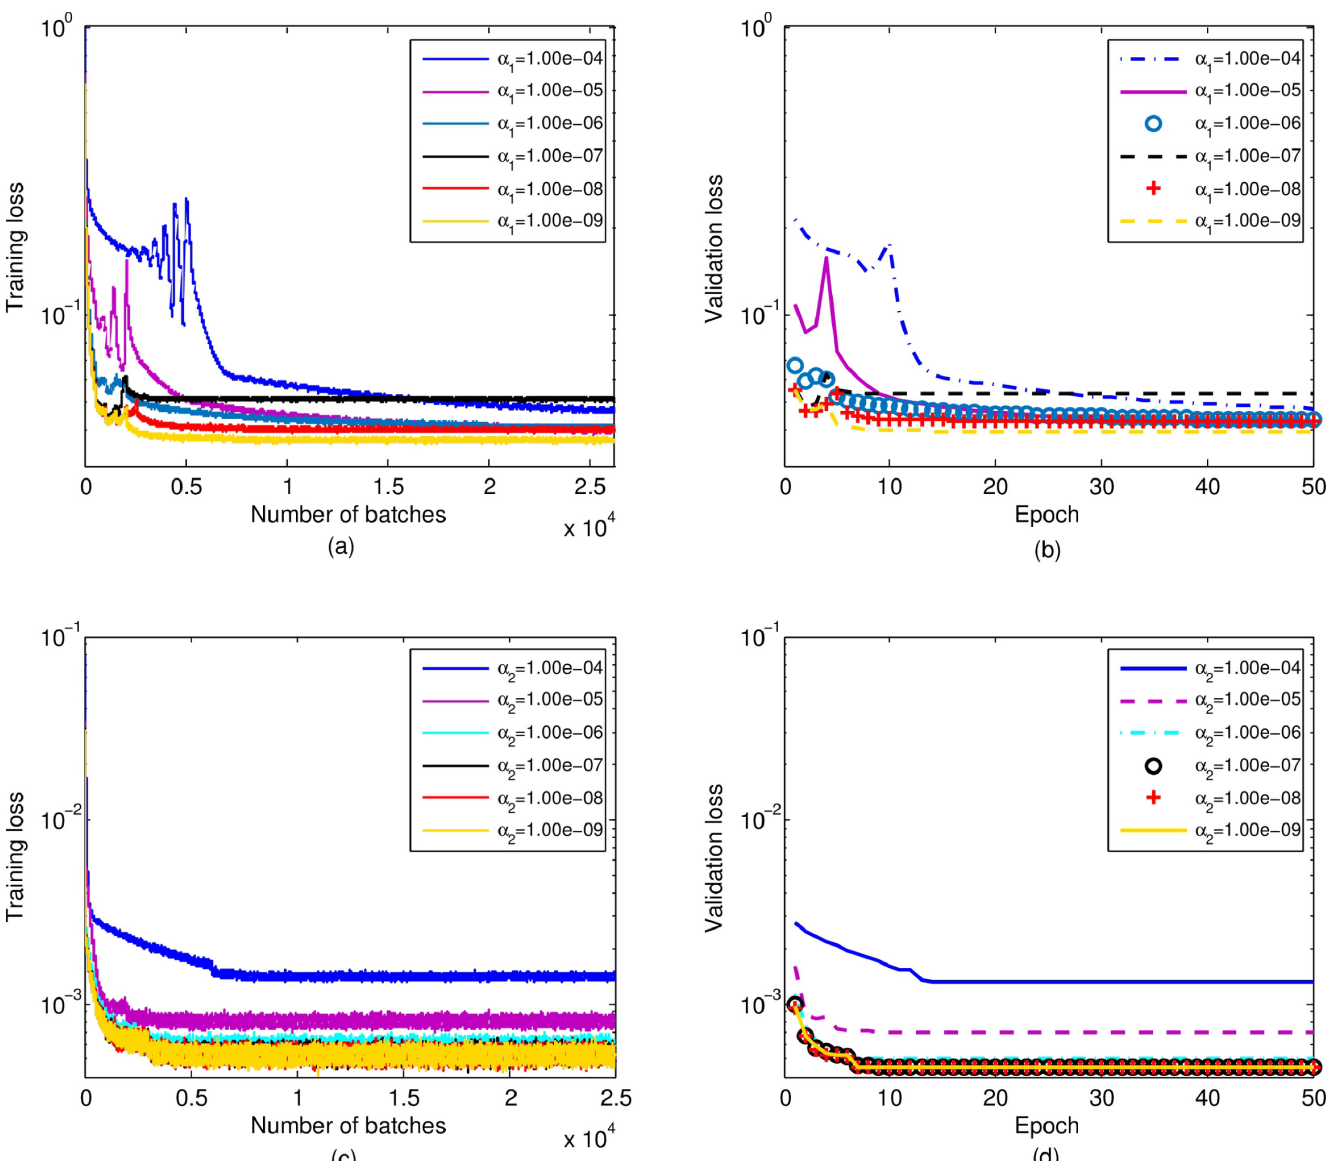
Fig 4. (a) Training loss of the detection network. (b) Validation loss of the detection network. (c) Training loss of the reconstruction network. (d) Validation loss of the reconstruction network.